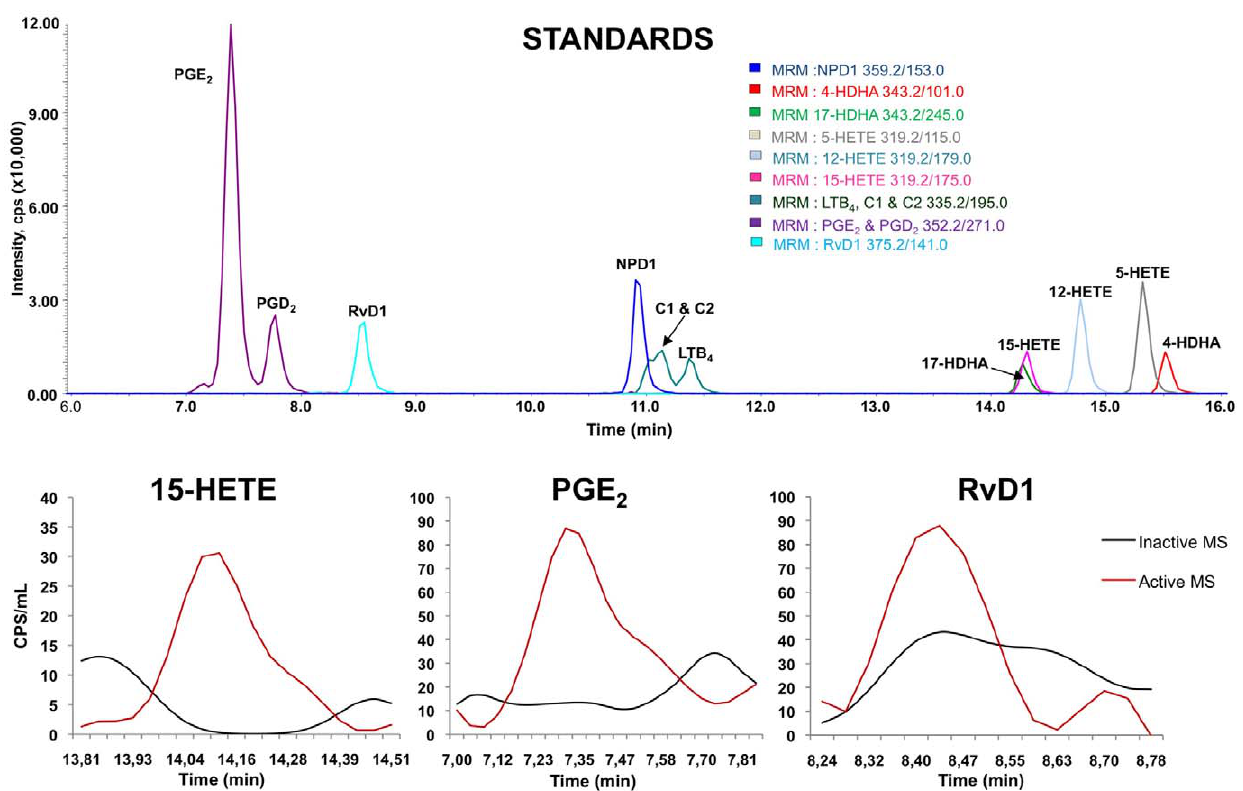
Figure 1. LC/MS/MS Lipid Mediator Profiling. A) MRM profile of 12 eicosanoid and docosanoid synthetic standards (NPD1, 4-HDHA, 17-HDHA, RVD1, PGE 2 , PGD 2 , LTB 4 , 6-trans LTB 4 (C1), 6-trans-12-epi-LTB 4 (C2), 12-HETE, 15-HETE, 5-HETE). B) Representative MRM chromatogram of 15-HETE, PGE 2 and RvD1 from patients with less active MS (black line) and with highly active MS (red line). MRM signals (CPS) were corrected for recovery and cerebrospinal fluid sample size. Calibration curves (1–1000 pg) and specific LC retention times for each compound were established with synthetic standards (Cayman Chemical, Ann Arbor, MI). Structures were confirmed for selected samples by MS/MS analyses using enhanced product ion mode with appropriate selection of the parent ion in quadrupole 1. (precursor lipids) of AA ( P= 0.69) or docosahexaenoic acid